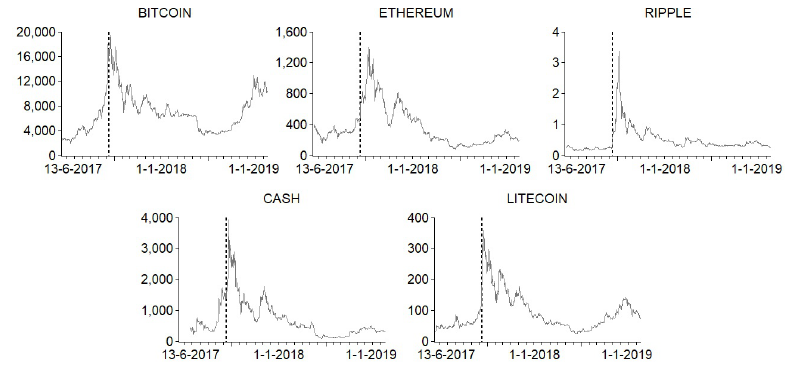
Figure A1. Cryptocurrency